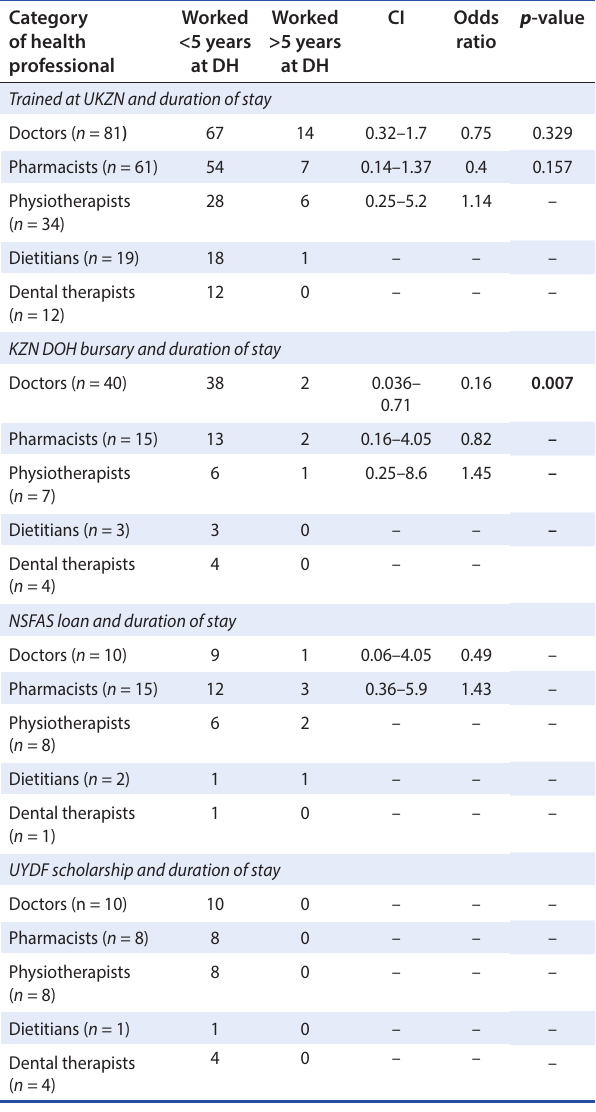
Table 4: Association between training at UKZN, funding source and duration of stay > 5 years at